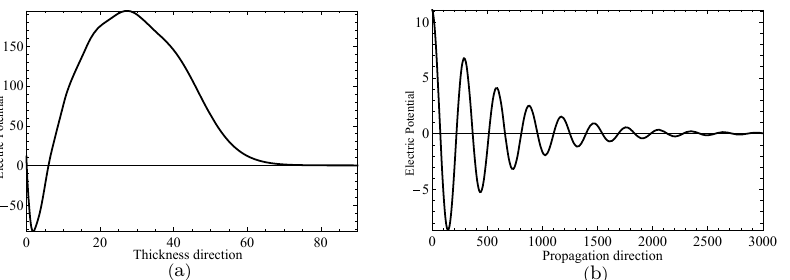
Figure 12. Electric potential distributions for thickness direction in ( a ) and propagation direction in ( b ) when f = 24.07 Hz, ξ = 2.1365 + 0.1694 i .